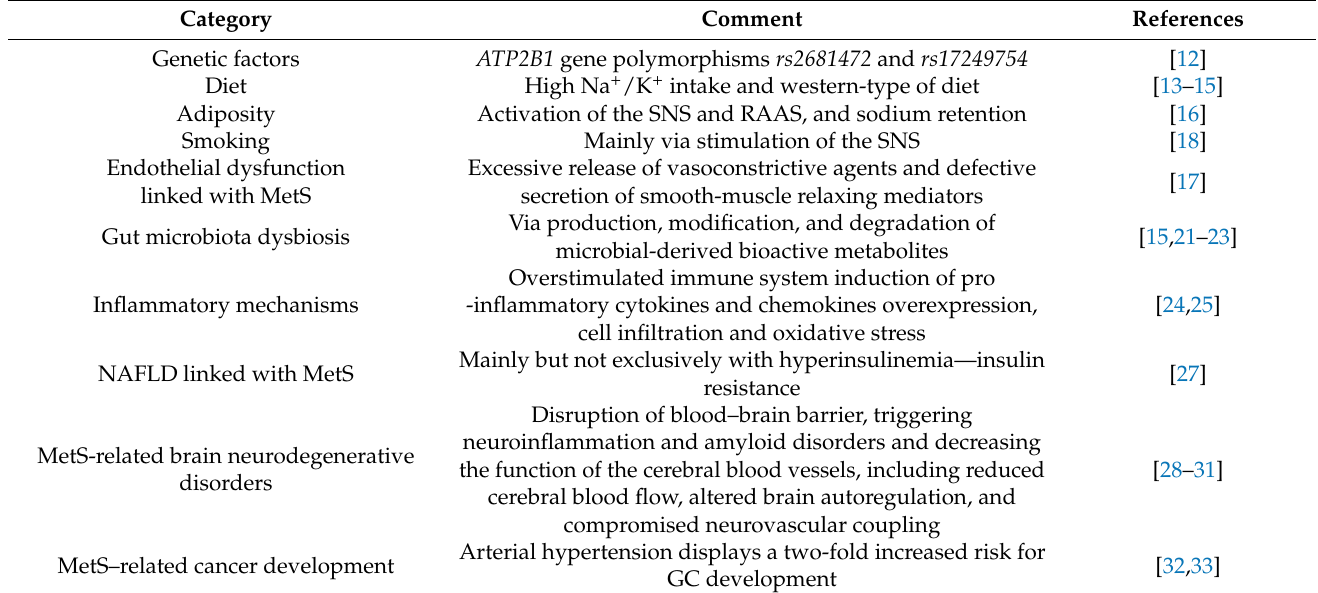
Table 1. Synopsis of potential etiologic agents of MetS-related arterial